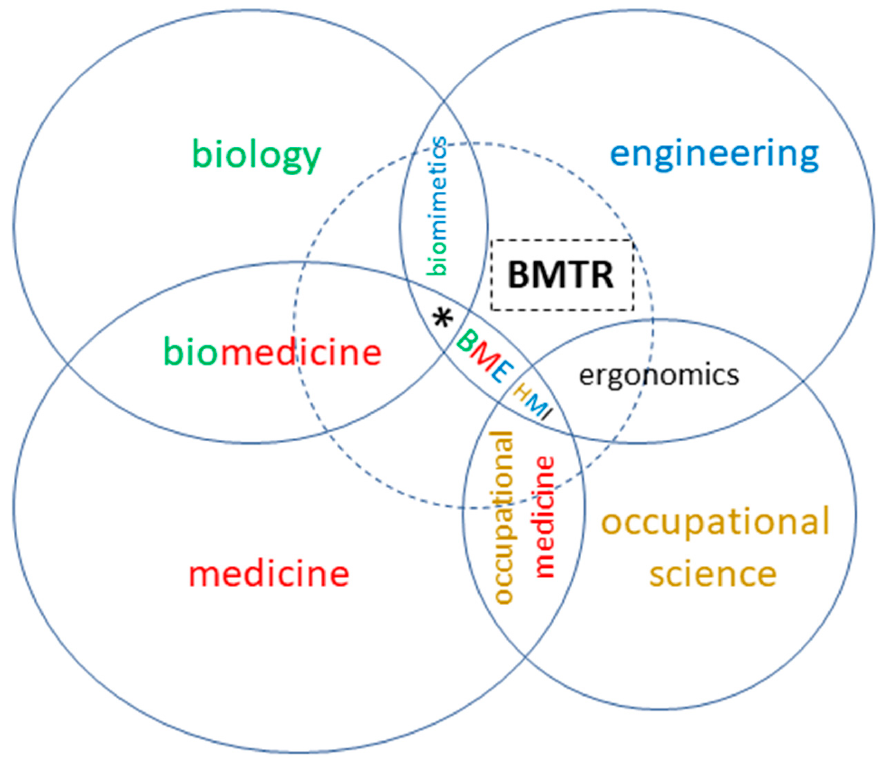
Figure 1. Activities of biomechatronics in relation to the related scientific fields (dashed circle). BMTR: biomechatronics; BME: biomedical engineering; HMI: human–machine interaction; Asterisk *: engineering for biology (“E4B”).